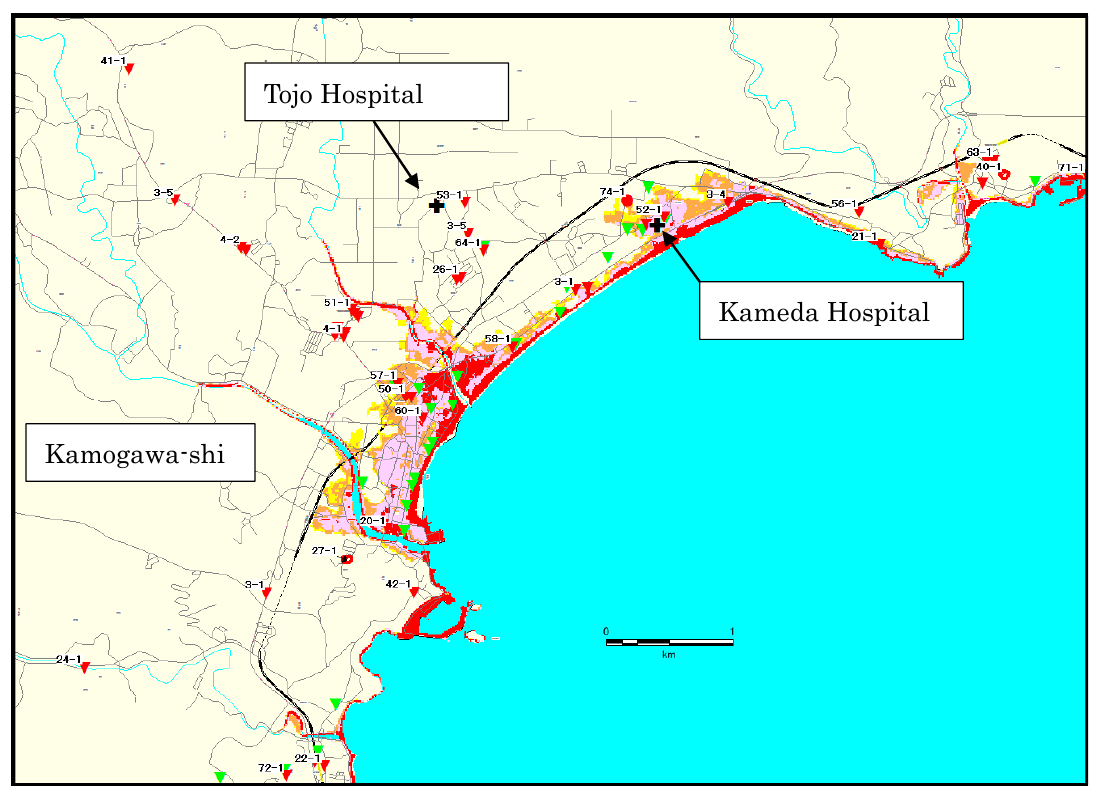
Figure 7. The map of the scenario information in Kamogawa-shi. The red reverse triangles show the location of a hypothetical event, and the number shows the providing information in Figure 6. The green reverse triangles denote the evacuation facilities. The red and pink areas show tsunami inundation areas in this scenario.